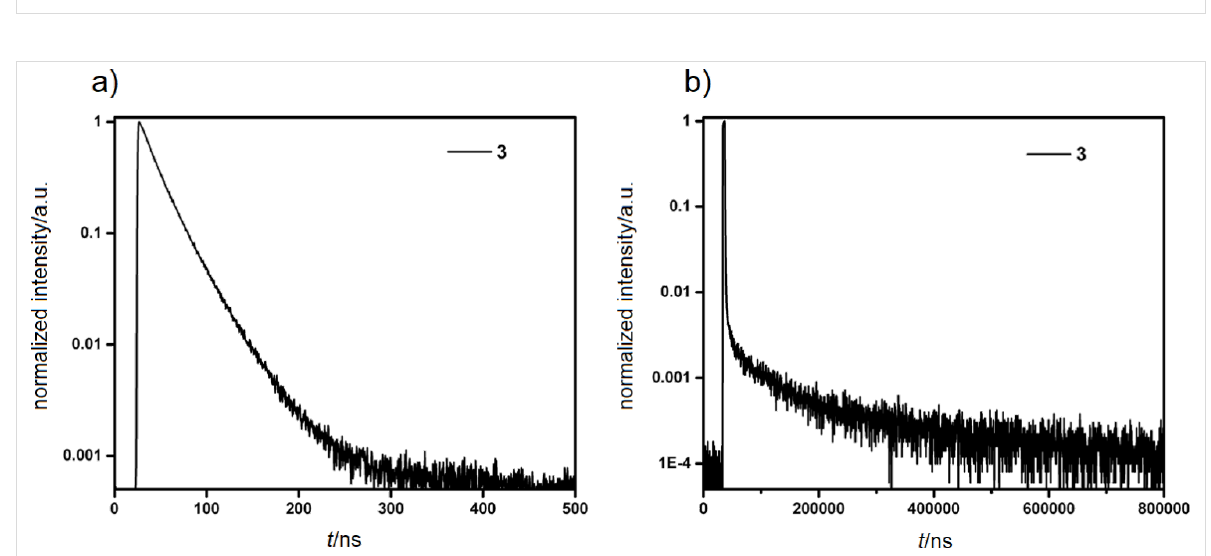
Figure 6: Time-resolved PL plots. a) Prompt decay and b) delayed decay curve of 3 in thin film ( λ exc = 378 nm).